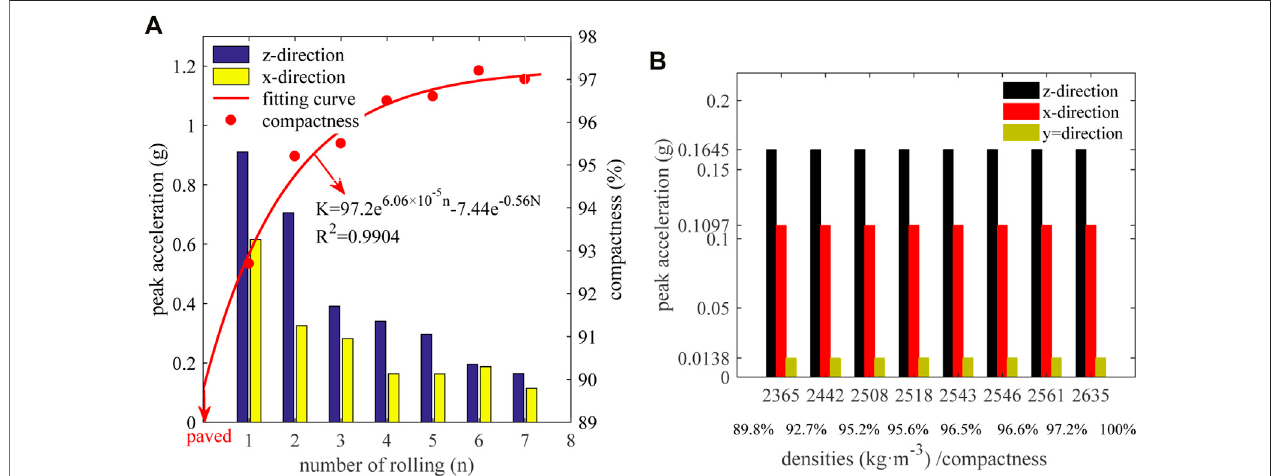
FIGURE 13 | (A) Compactness during the rolling process; (B) in fl uence of density on acceleration.